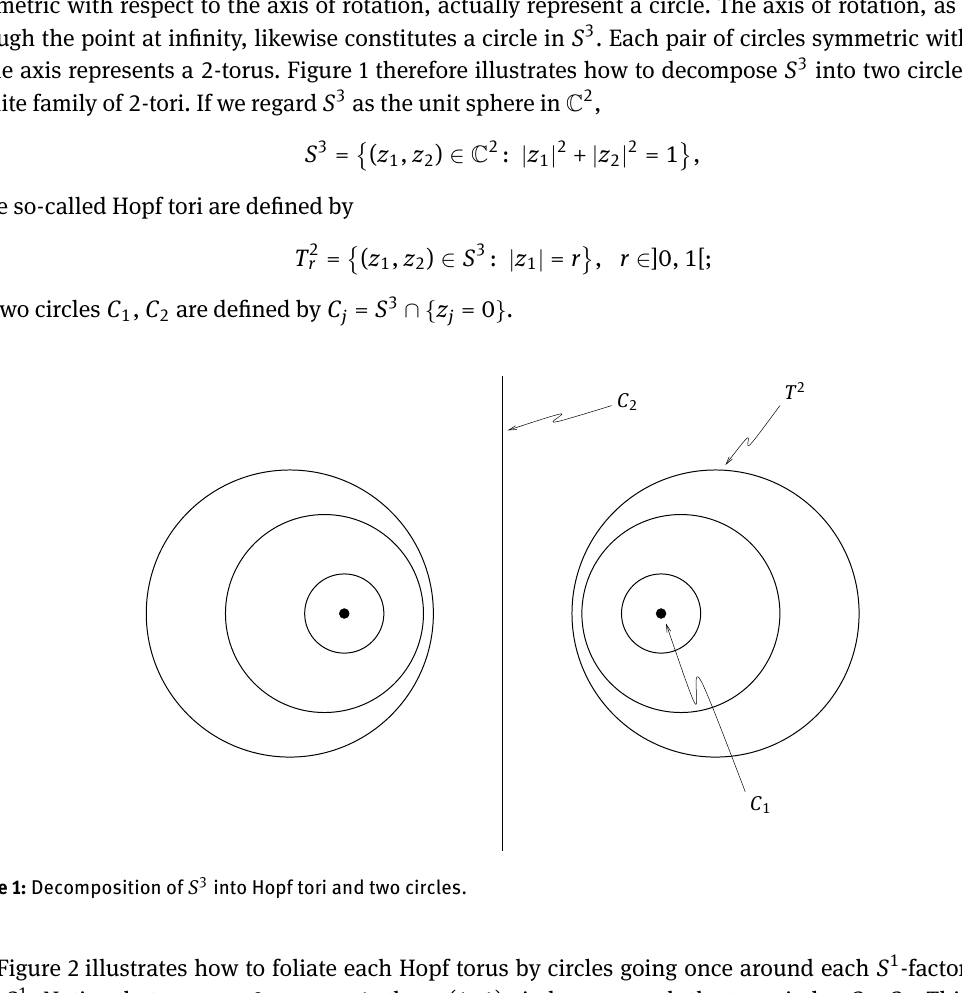
S 1 × S 1 . Notice that as r → 0 or r → 1, these (1, 1)-circles approach the two circles C 1 , C 2 . This